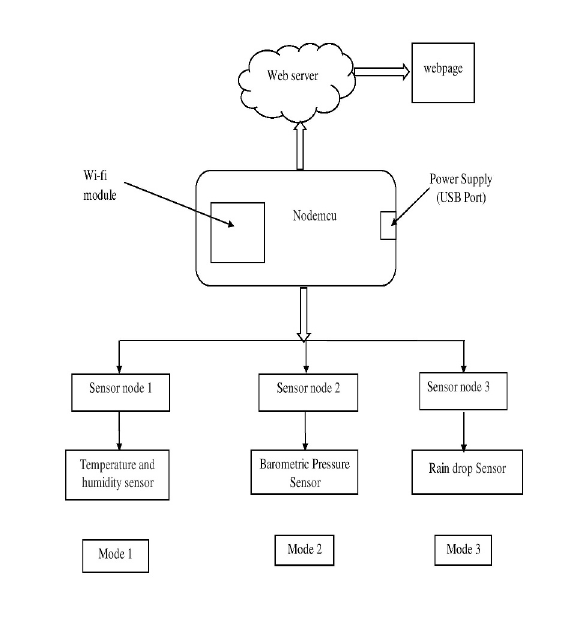
Fig 1.: The proposed model architecture of weather monitoring system.